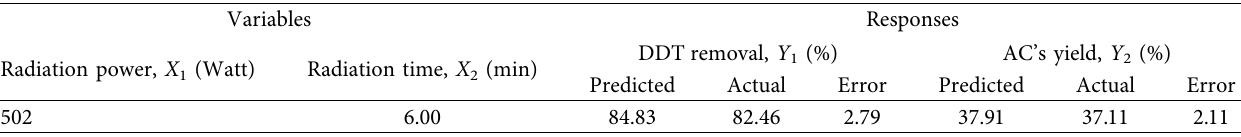
Table 5: Model validation for CSAC’s preparation.